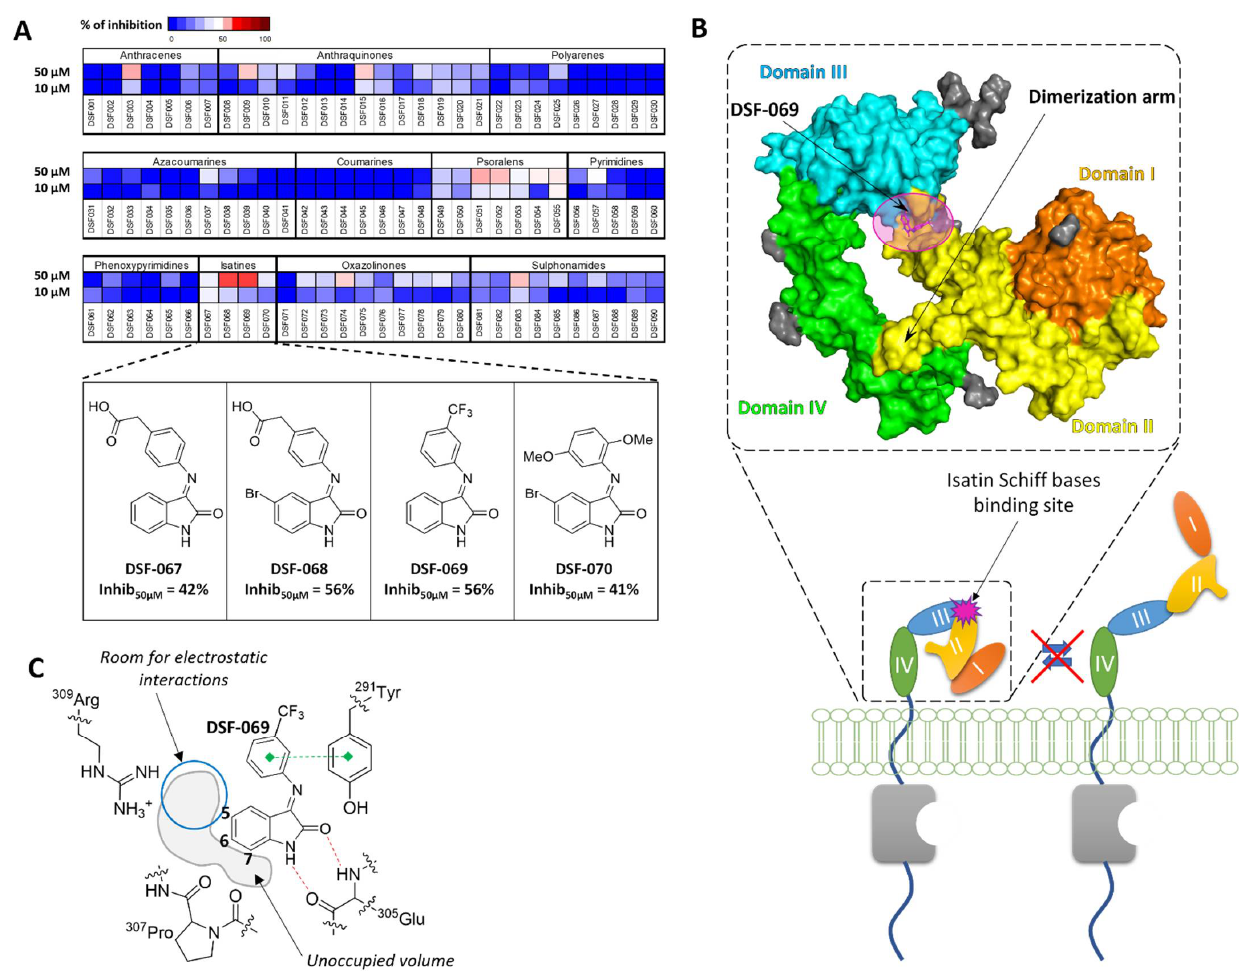
Figure 2. ( A ) Heat-map representing the percentage of EGFR dimerization inhibition at 50 and 10 μM. Structures and percentage of inhibition at 50 μM for the most interesting isatin Schiff bases are reported. ( B ) Top: binding site predicted for DSF-069 (highlighted with magenta circles) on EGFR-ECD (surface representation). Glycans are depicted as gray spheres. Bottom: schematic representation of the binding site for isatin Schiff bases on EGFR-ECD and proposed mechanism of action, i.e., block of the receptor in the inactive/closed conformation. ( C ) Details of the interactions (docking simulation) between DSF-069 and EGFR-ECD. Hydrogen bonds are depicted as red dashed lines; π-π interaction is depicted as green dashed line. The volume unoccupied by DSF-069 is highlighted in gray. The possibility to functionalize the molecule with an electron-dense group is also shown.